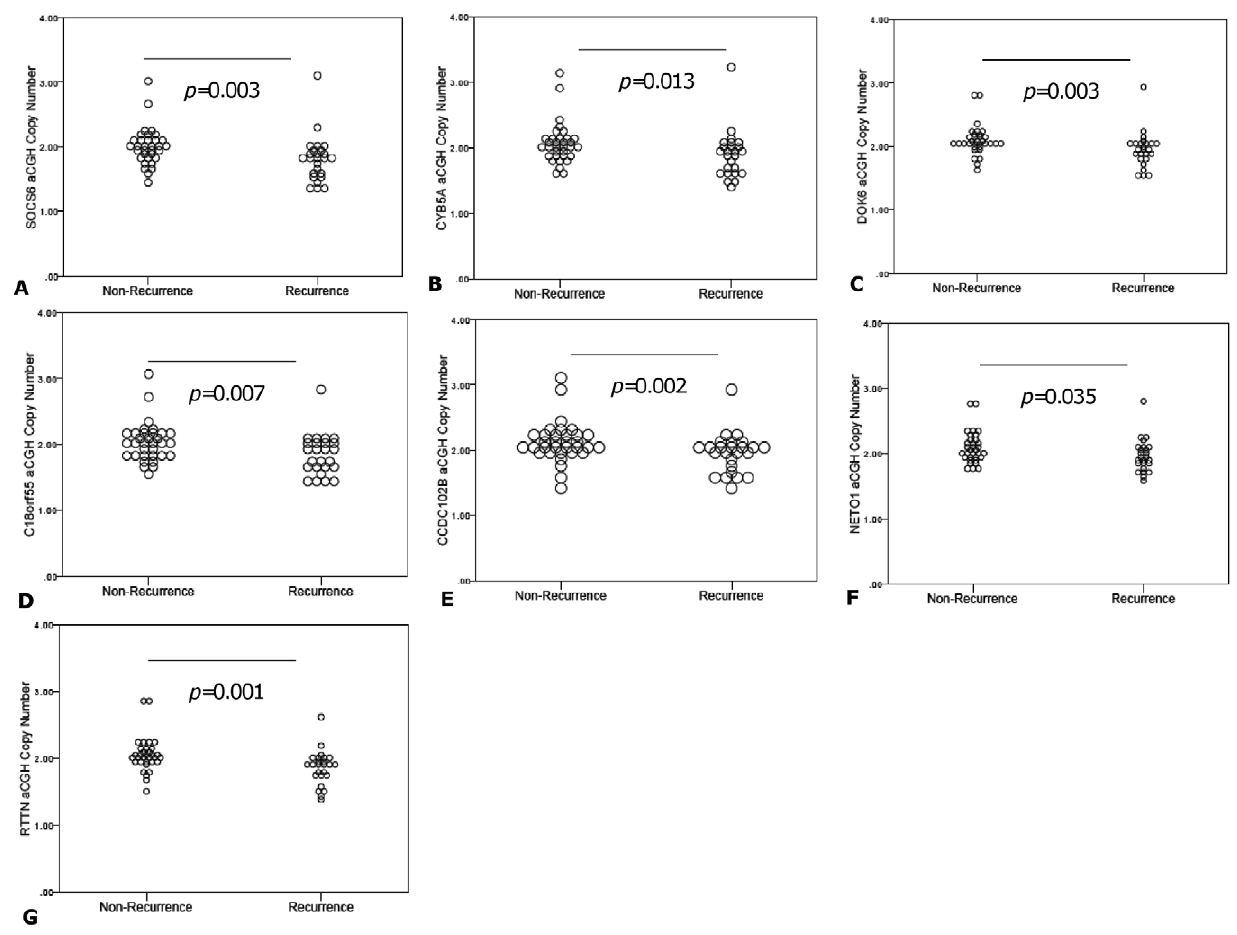
Figure 2. aCGH copy number of genes within 18q22.3 demonstrating preferential loss in SCC recurrence. The Y-axis represents the derived DNA copy number from aCGH log2 normalized data and the X-axis represents the recurrence phenotype. Mann-Whitney U test to was used to assess for any differences in copy number between recurrence phenotypes and p values , 0.05 were deemed significant.